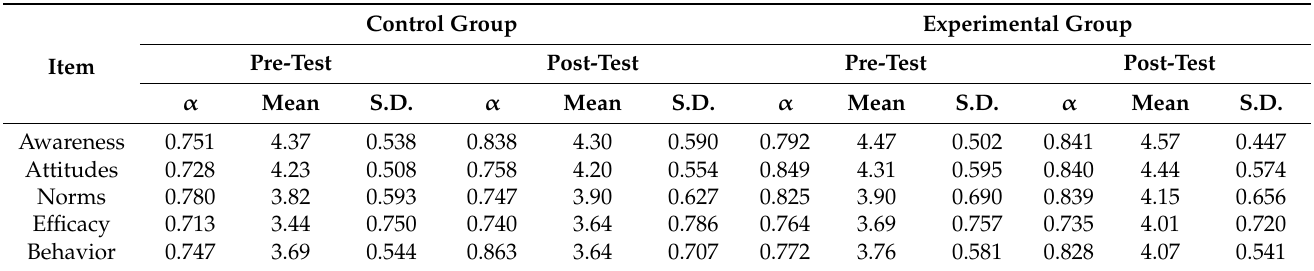
Table 4. Cronbach’s alpha, mean and standard deviation of survey constructs.